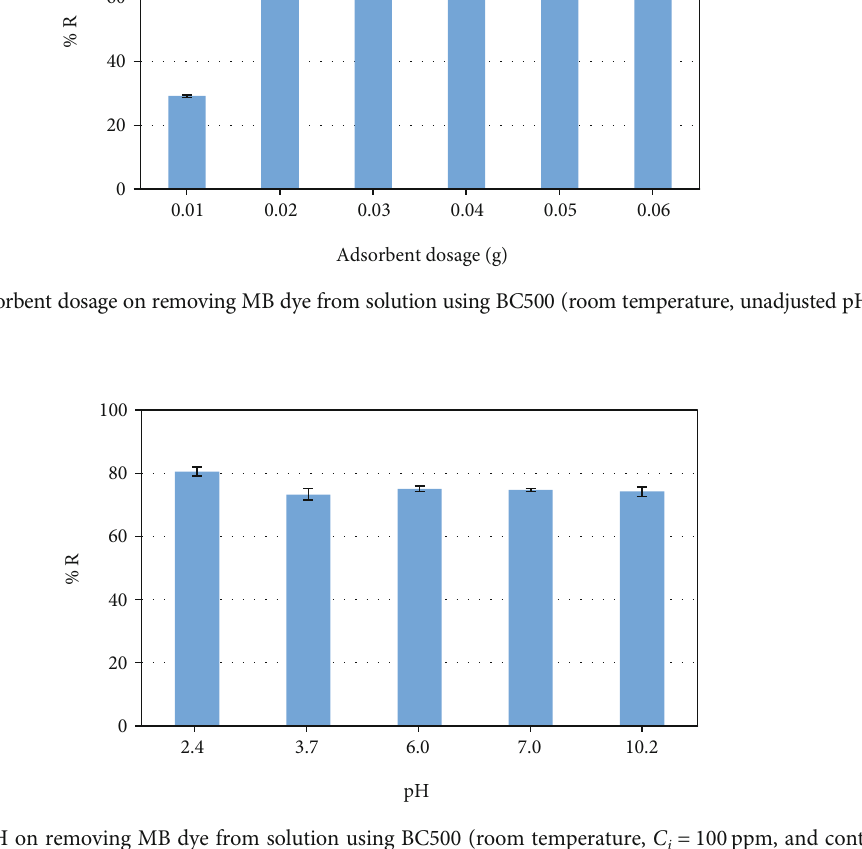
i = 100ppm , and contacttime = 3 h ).